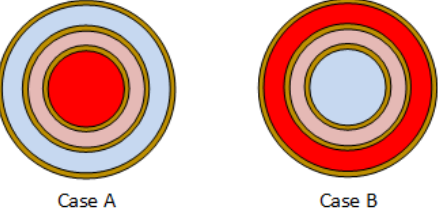
Figure 3. Case A and Case B configuration of hot and cold streams within the triplex heat exchanger.